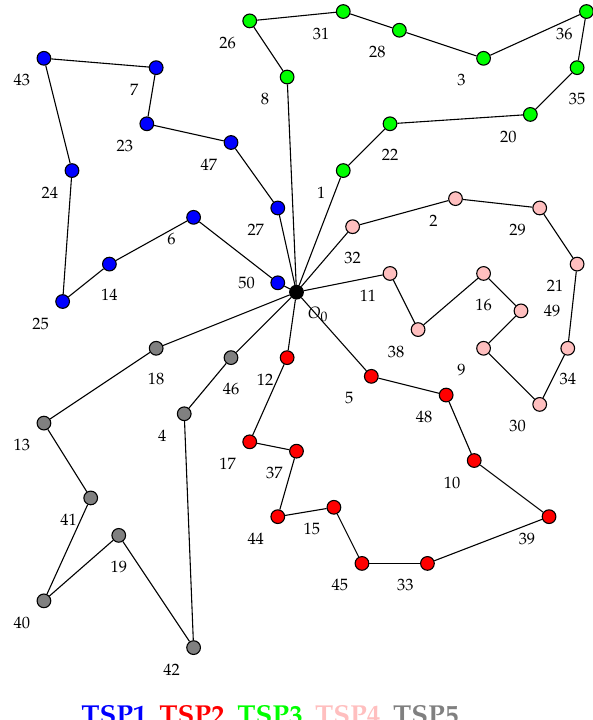
Figure 6. Tour for 5TSP51.